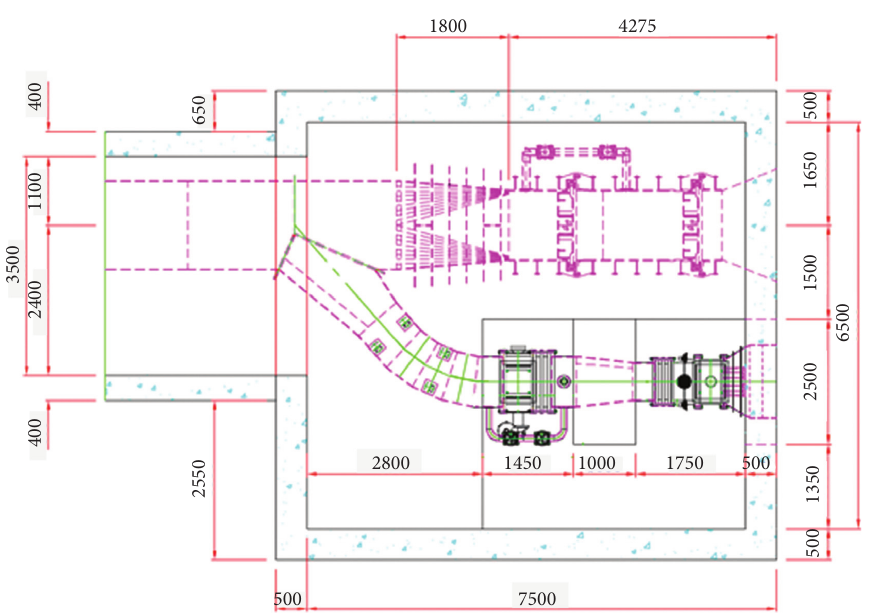
Figure 1: Geometric details of Sardab Dam’s bottom outlet (all dimensions are in mm). Table 2: The flow rate passing through the channel in the openings of service gates and different